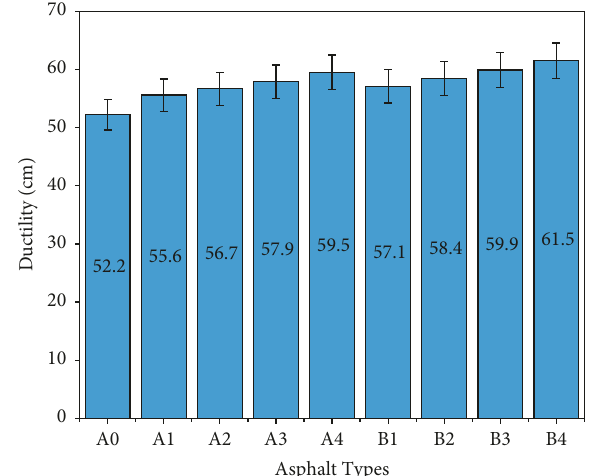
Figure 6: Effects of different GO dosages on the ductility of bio-asphalts.